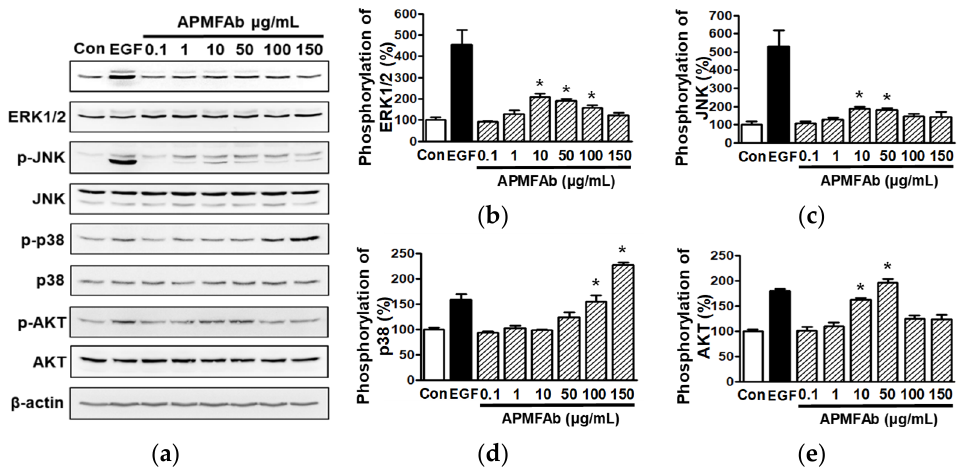
Figure 3. Effect of Angelica polymorpha Maxim. flower absolute on the phosphorylation of kinases in HaCaT cells. HaCaT cells were treated with or without APMFAb (0.1–150 μ g/mL) for 10 min. Cell lysates were immunoblotted with antibodies of each kinase or β -actin. ( a ) Representative images. ( b – e ) Graphical representation of phosphorylated ERK1/2 ( b ), JNK ( c ), p38 MAPK ( d ), and AKT expression levels ( e ) shown in panel ( a ). Kinase phosphorylation levels are expressed as percentages of levels in non-treated controls (Con). Recombinant human epidermal growth factor (EGF: 5 ng/mL) was used as the positive control. Results are presented as means ± SEMs ( n = 3/protein). * p < 0.05 vs. non-treated cells. p-ERK 1/2, phosphorylated ERK 1/2; p-JNK, phosphorylated JNK; p-p38, phosphorylated p38 MAPK; p-AKT, phosphorylated